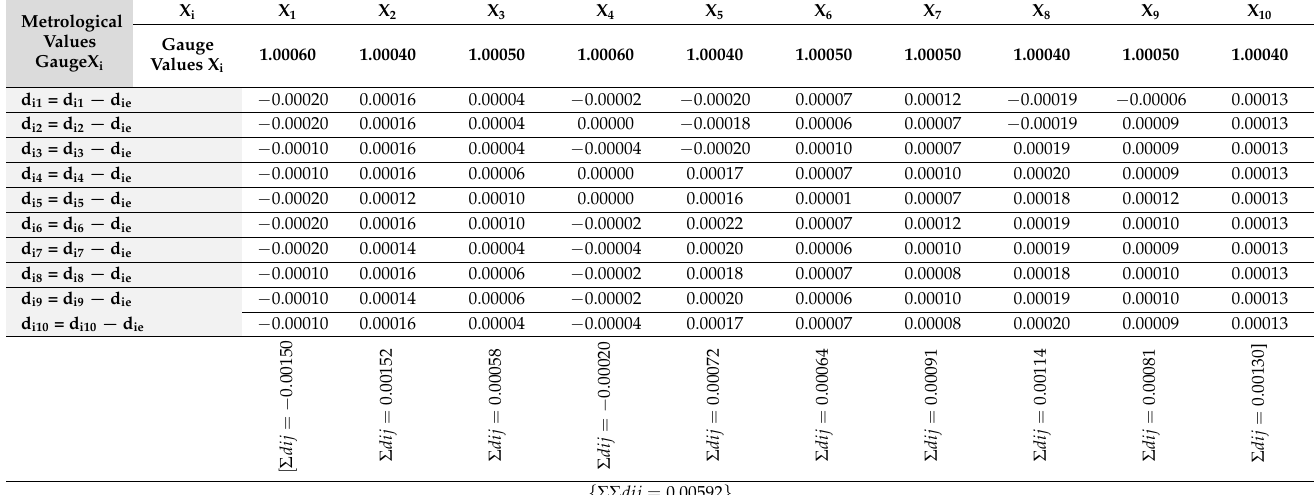
Table 2. Protocol of metrological measurements for determination of metrological values (E1 mm